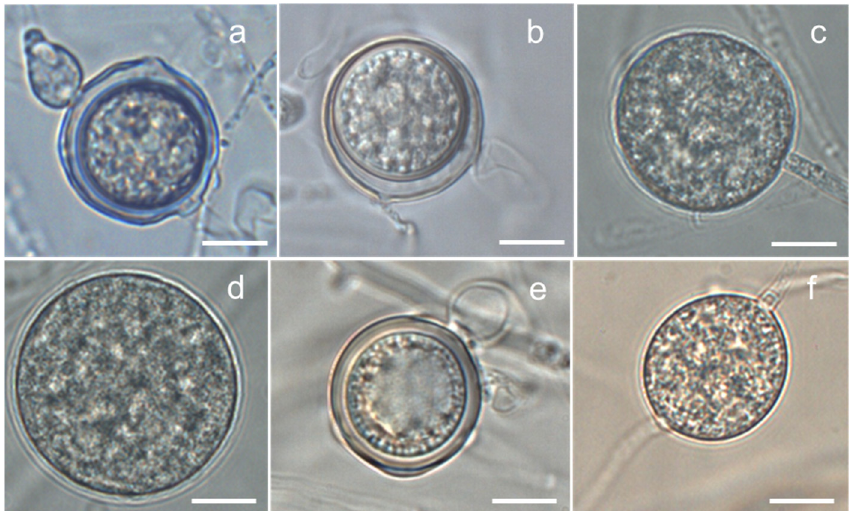
Figure 3. Oospores or sporangia of Globisporangium spp. isolated from the Sanionia moss in Ny-Ålesund, Spitsbergen Island, Norway: ( a ) aplerotic oospore of Globisporangium sp. 1 strain 10G16V2; ( b ) aplerotic oospore of Globisporangium sp. 2 strain 10G15W2 (= G. polare ); ( c ) globose sporangium of Globisporangium sp. 3 strain 10C17N1; ( d ) globose sporangium of Globisporangium sp. 4 strain 10G34N1; ( e ) plerotic oospore of Globisporangium sp. 5 strain 10C12N1; and ( f ) hyphal swelling of Globisporangium sp. 6 strain 10G26N1. Bars = 10 µm.